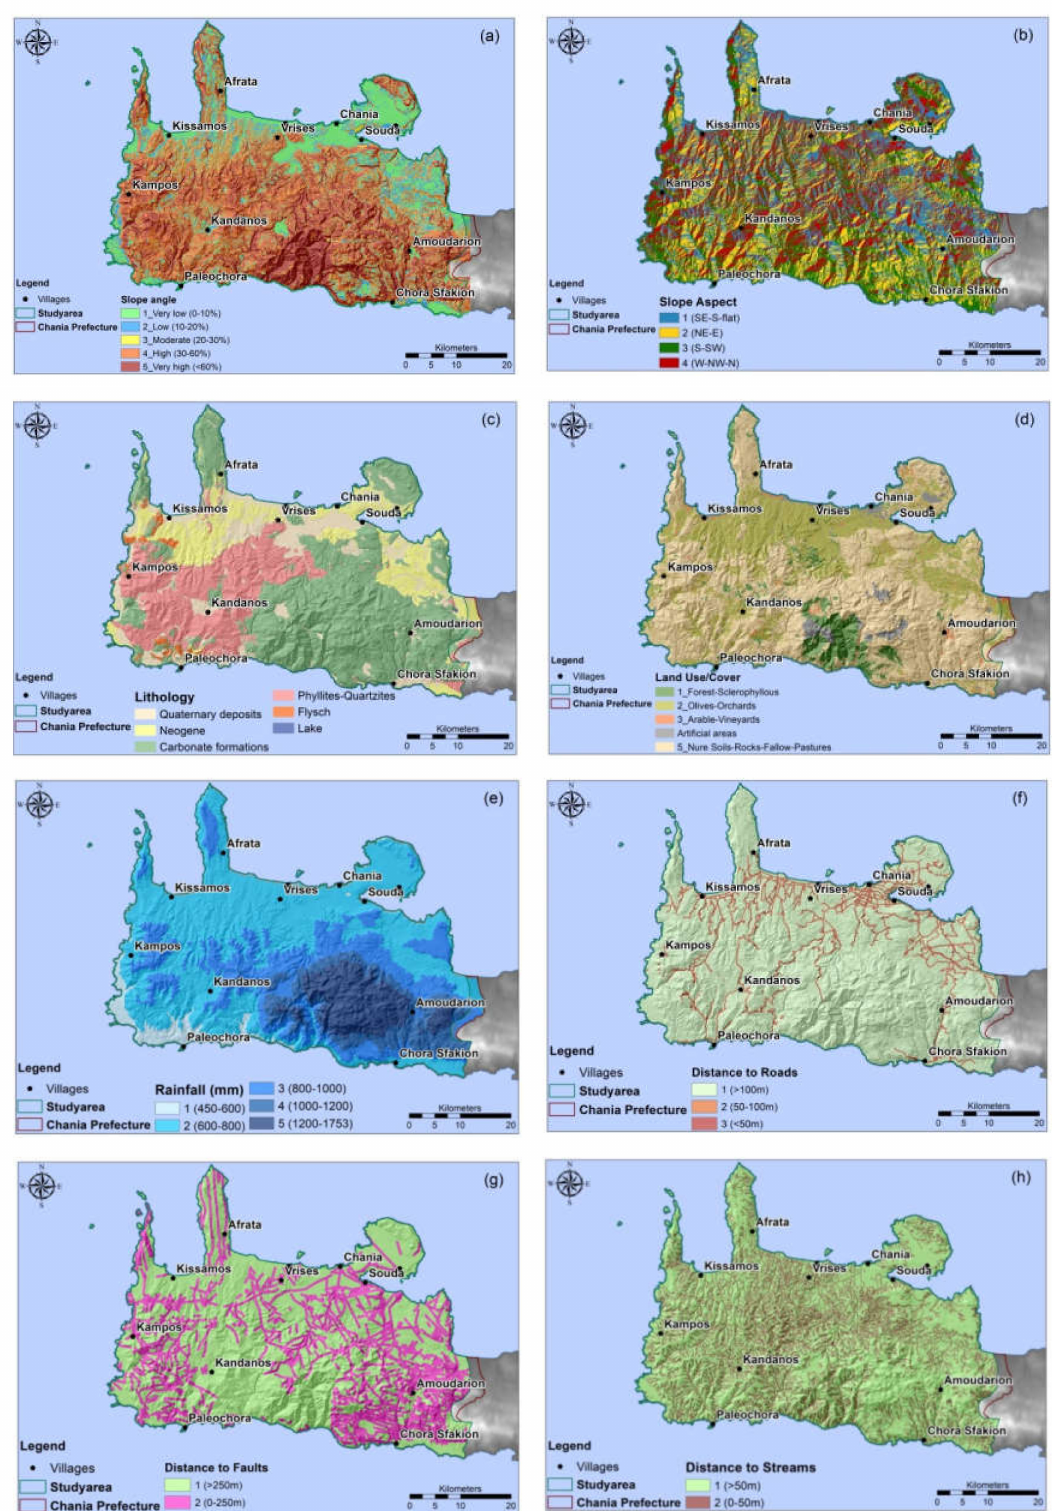
Figure 6. The thematic raster maps of the eight (8) factors, used for the estimation of Landslide Susceptibility of Chania Prefecture: ( a ) Slope angle, ( b ) Slope aspect, ( c ) Geology, ( d ) Land cover, ( e ) Mean annual precipitation distribution, ( f ) Distance to roads, ( g ) Distance to faults, ( h ) Distance to